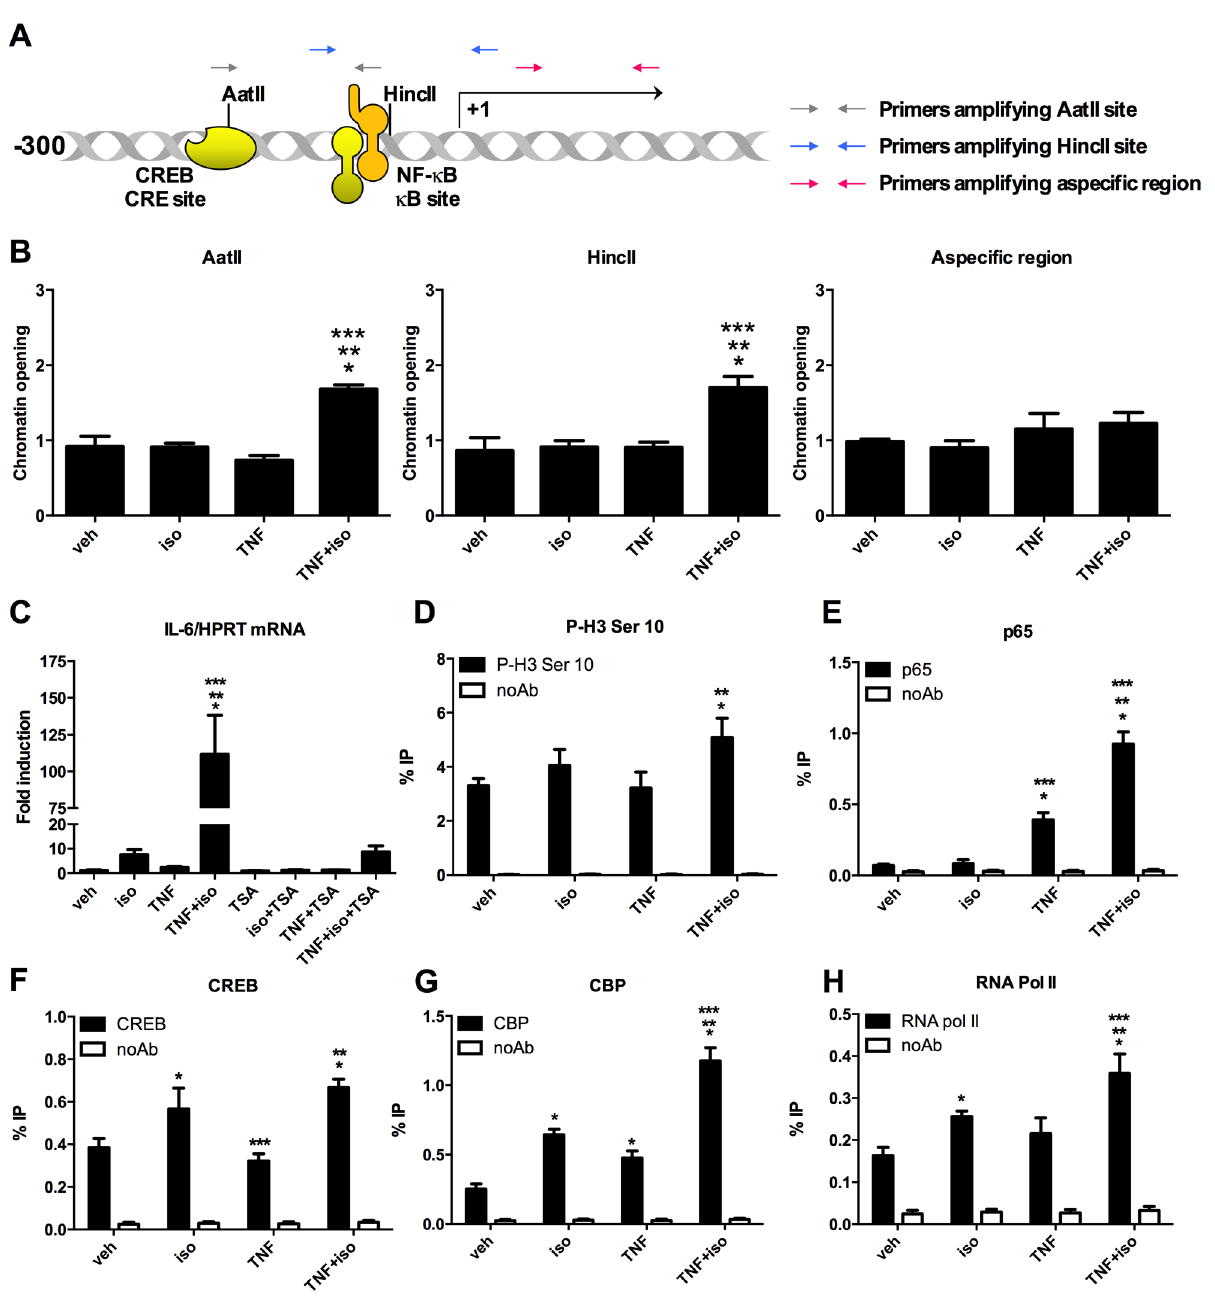
Figure 5. TNF- a /isoproterenol cotreatment induces chromatin remodelling and histone H3 modifications at the IL-6 promoter in C2C12 myotubes. (A) Schematic representation of the localisation of CREB- and NF- k B-responsive elements in the IL-6 promoter. Relative position of the recognition sites for AatII and HincII and primers used in the restriction enzyme accessibility assay via Real Time PCR (CHART-PCR) are indicated. (B) TNF/iso cotreatment promotes accessibility of the IL-6 promoter. C2C12 cells were treated for 2 hours with veh, iso and/or TNF. Chromatin opening of the promoter region was determined by CHART-PCR as detailed in Materials and Methods. Results represent average 6 SD of three independent experiments. (C) Effect of TSA, a histone deacetylase inhibitor, on IL-6 transcription. C2C12 cells were treated for 2 hours with combinations of veh, TSA, iso and/or TNF. mRNA levels of IL-6 were determined via RT-qPCR. Results represent average 6 SD of three independent experiments. (D) TNF/iso cotreatment enhances phosphorylation of histone H3 at the IL-6 promoter. C2C12 cells were treated with veh, iso and/or TNF for 2 hours. Phosphorylation of histone H3 at serine 10 was determined via ChIP. Results represent average 6 SD of three independent experiments. (E-H) Effect of TNF and/or iso treatment on the recruitment of NF- k B, CREB, CBP and RNA polymerase II to the IL-6 promoter. C2C12 cells were treated with veh, iso and/or TNF for 2 hours. Recruitment of NF- k B p65, CREB, CBP and RNA polymerase II was measured via ChIP. Results represent average 6 SD of three independent experiments. (*) Significantly different from veh. (**) Significantly different from TNF. (***) Significantly different from iso.